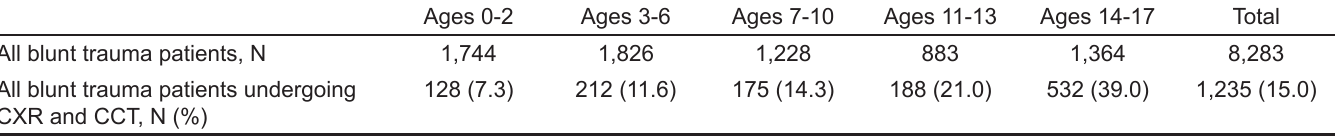
Table 1. Proportion of pediatric blunt trauma patients undergoing screening for intrathoracic injury.